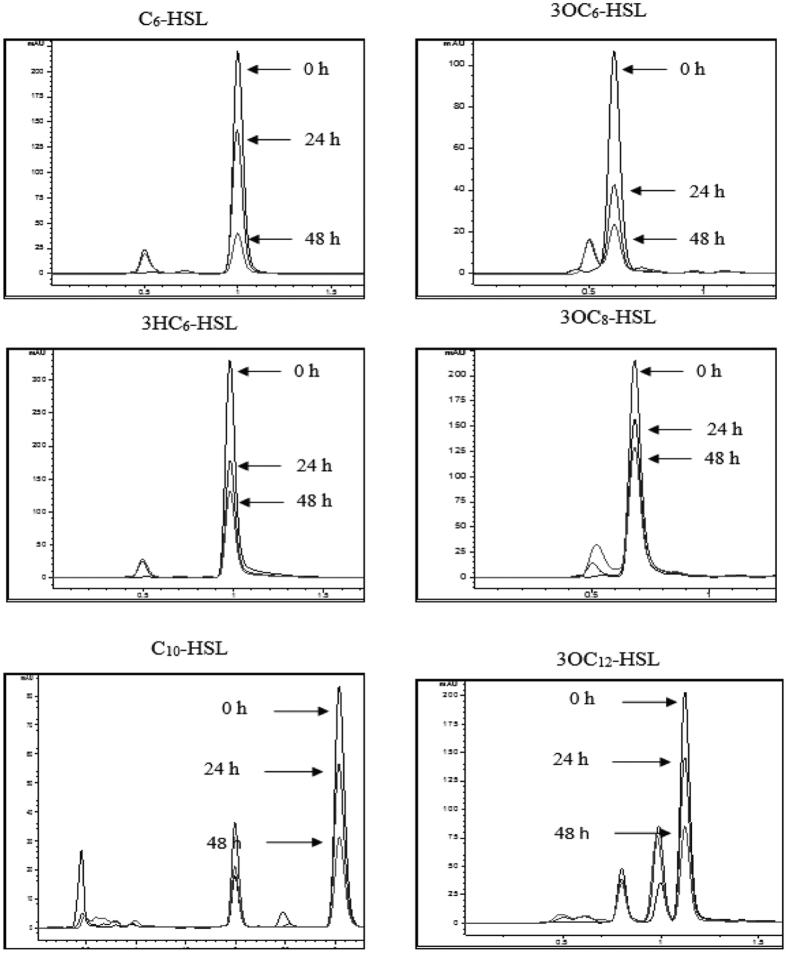
Analysis of P. versutus L10.15T AHL degradation by RRLC.